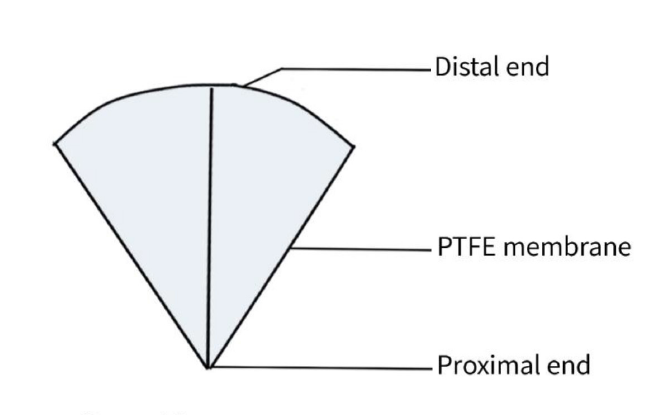
Fig. 1A – Tailored PTFE membrane. PTFE=polytetrafluoroethylene Fig. 1B – Design of the PTFE membrane valve. MPA=main pulmonary artery